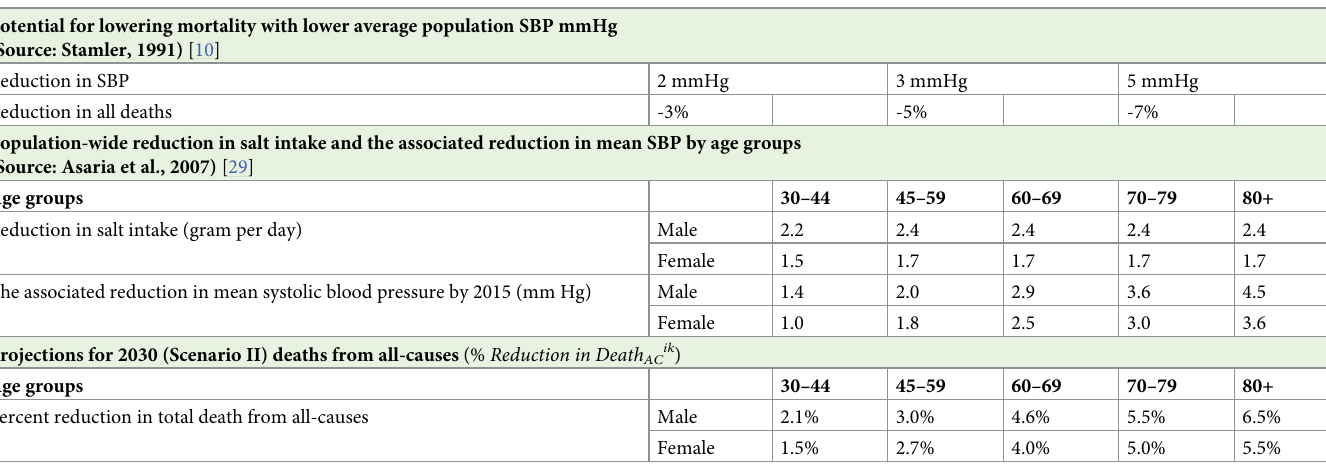
6% reduction in deaths for the 4 mmHg reduction in SBP (i.e. the average of the reductions in deaths between 3mm Hg and 5 mm Hg reduction); calculated the percent reduction in death per mmHg reduction of salt intake at 2, 3, 4, and 5 mmHg; assigned interpolated values for in- between mmHg reductions by taking averages of the reduction in death (%) per mmHg reduc- tion in salt; and then derived the gender and age-group specific percent reductions in total deaths. The bottom panel in Table 3 shows the percent reduction in total death from all-causes used in this study for the 2030 Scenario II projections, which are based on the findings from Stamler (1991) and Asaria et al. (2007) in the top and middle panel. Accordingly, the projected total deaths from all causes in 2030 in Scenario II is derived from the corresponding total deaths that were predicted under status quo condition in 2030, as displayed in Eq 7 below.